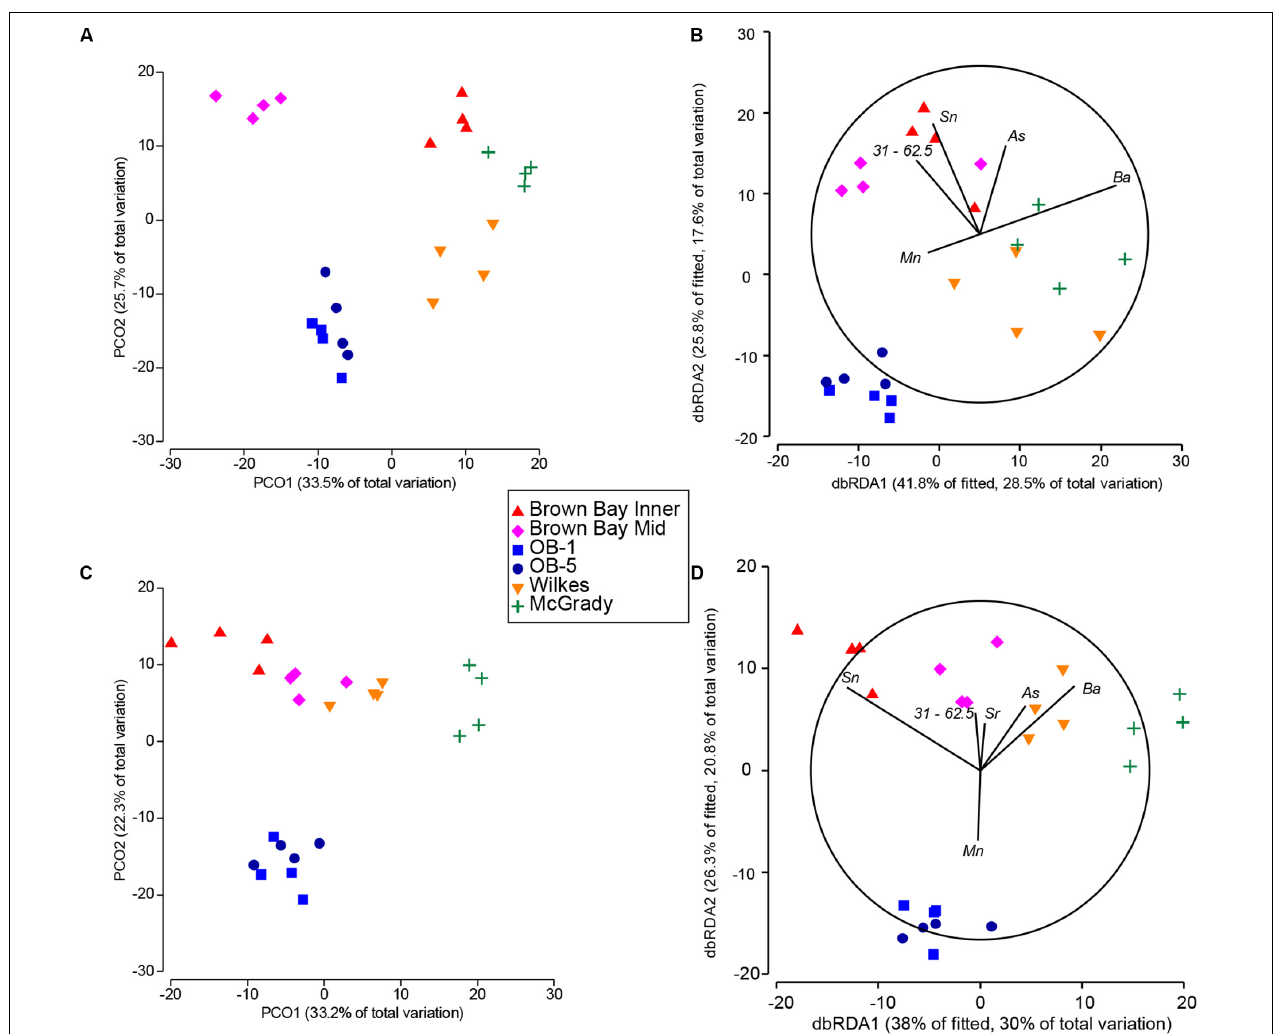
FIGURE 8 | Comparison of fitted DSTLM environmental models with respective PCO ordinations of nematode and copepod communities. (A) PCO ordination of nematode communities; (B) dbRDA ordination of fitted best environmental model explaining nematode community patterns; (C) PCO ordination of copepod communities; (D) dbRDA ordination of fitted best environmental model explaining copepod community patterns. Sb (antimony) represents iron, lead and